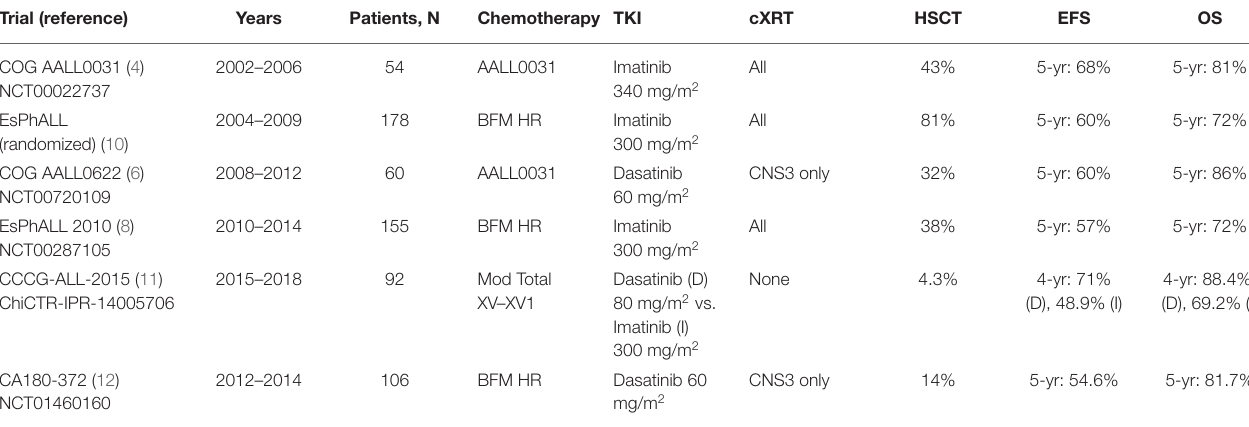
TABLE 1 | Summary of published trials investigating TKIs for Ph + ALL in children and adolescents. Trial